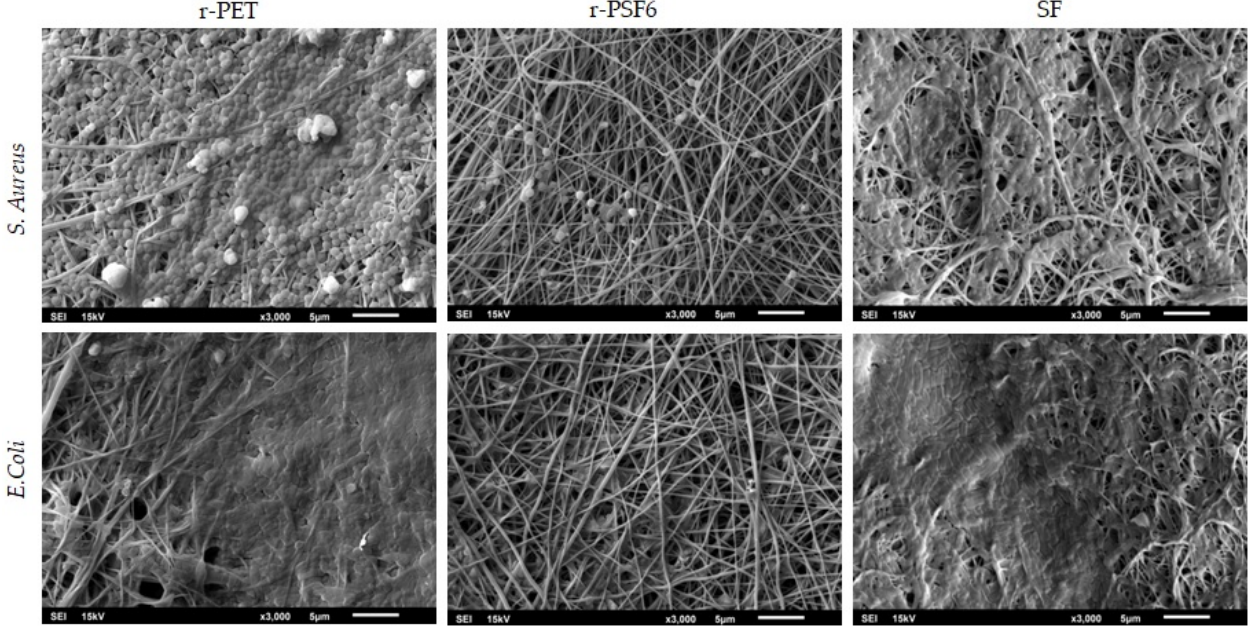
Figure 9. SEM micrographs of r-PET and r-PSF6 and SF show antibacterial efficiency against S. Aureus and E. Coli.